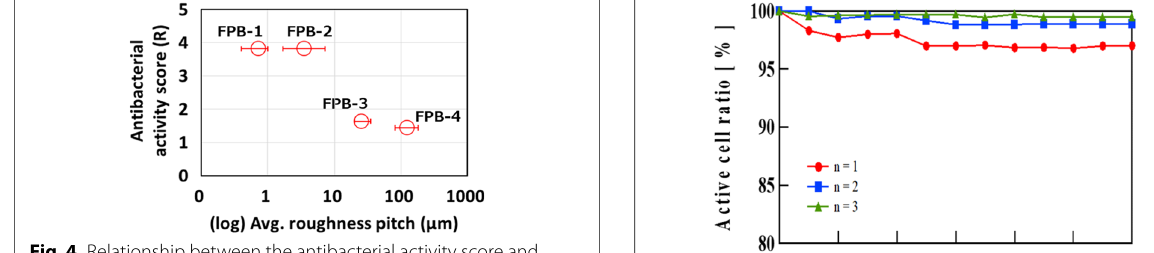
Fig. 4 Relationship between the antibacterial activity score and roughness pitch of FPB-treated surfaces